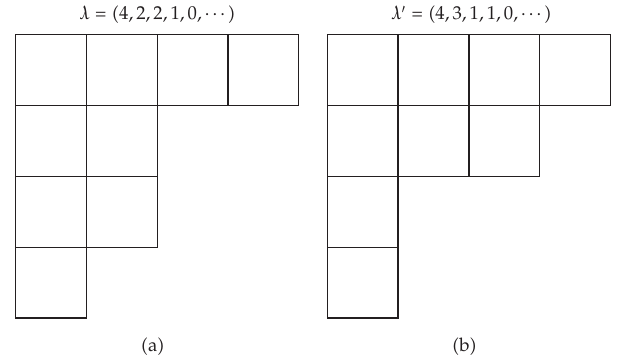
Figure 4: Young diagram and its